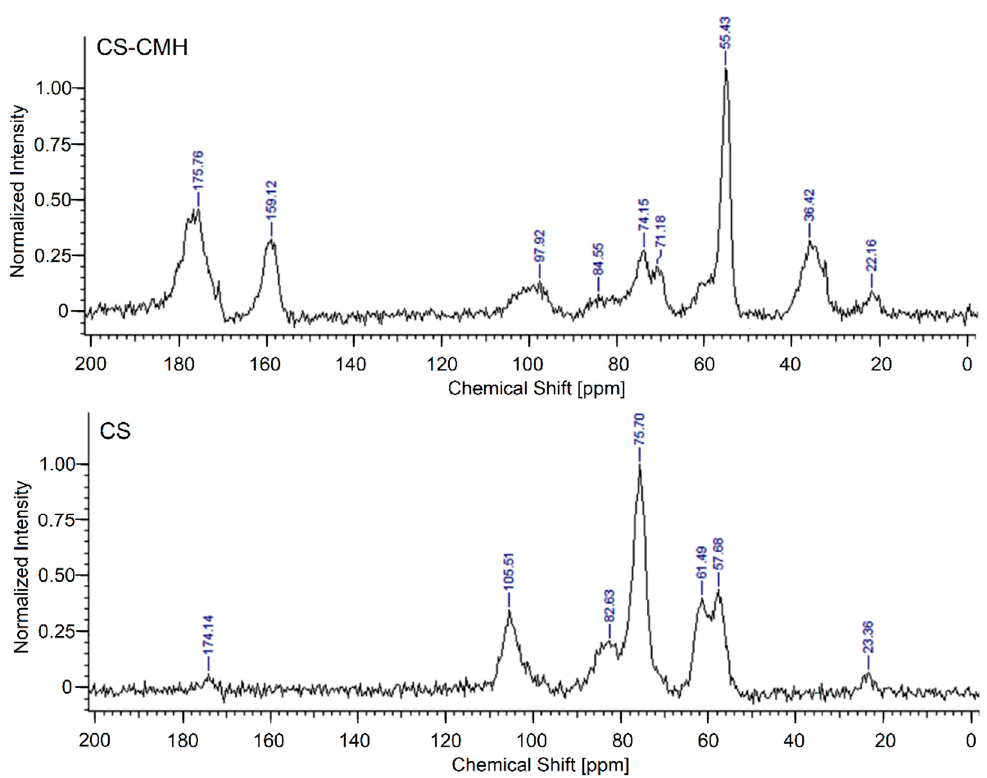
Figure 4. Solid-state 13 C NMR spectra of the CS and CS-CMH.